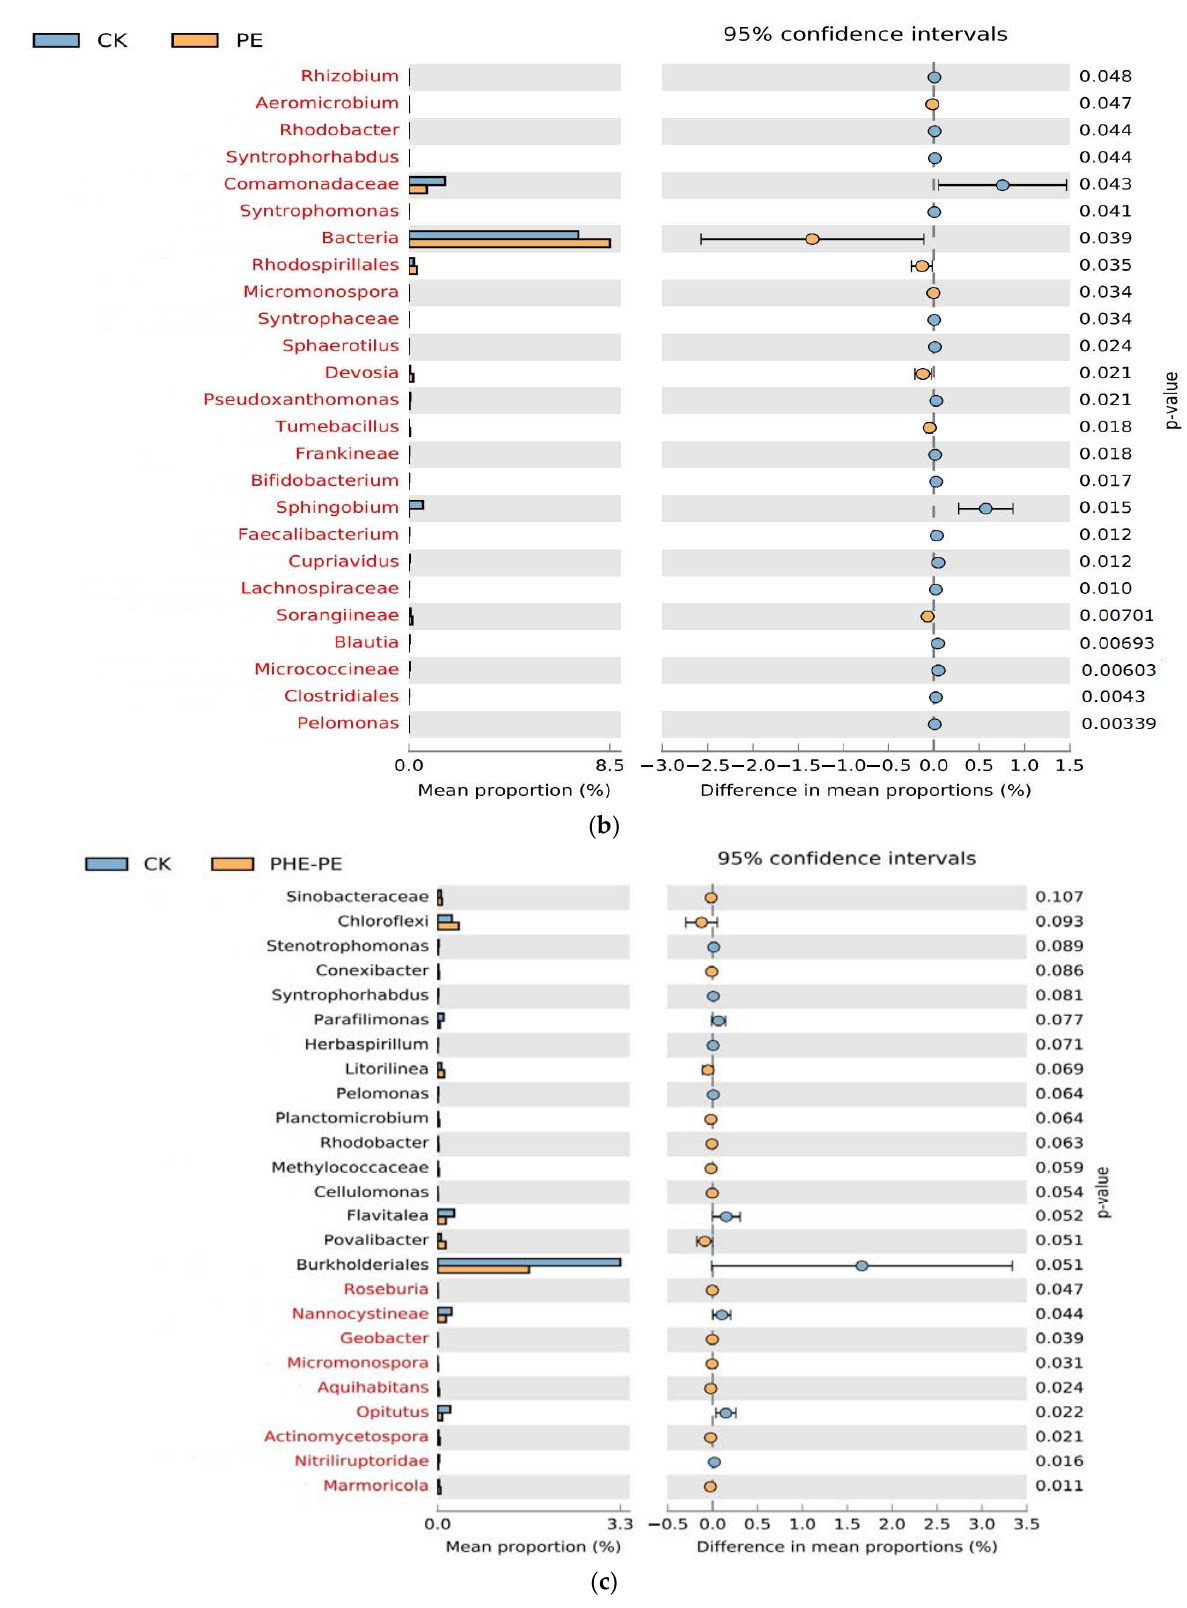
Figure 3. STAMP plots of difference analysis between CK and soils treated with: ( a ) PHE; ( b ) PE; ( c ) PHE ‐ PE. Only the 25 genera with the lowest p value are listed; p < 0.05 indicates significant difference, marked in red.